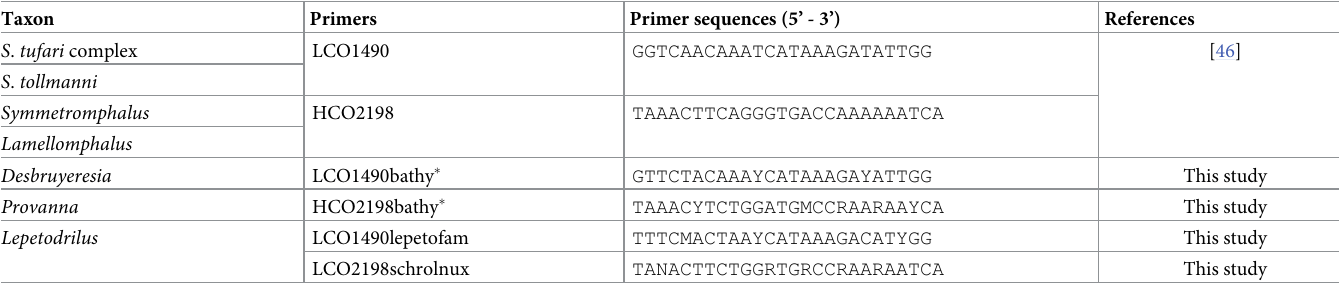
Table 2. Primers used in the present study for each